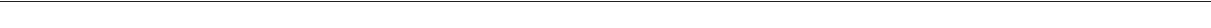
Fig. 6 Analysis of apoptotic vulnerabilities a – h Cells were incubated with increasing concentrations of the a BCL-X L -speci fi c inhibitor, b BCL-2-speci fi c inhibitor, e MCL-1 and g XIAP-speci fi c inhibitor for 96 h. Error bars are SEM ( n = 6 wells) and data is representative of three independent experiments. BCL-X L inhibitor c combined with PI3K/mTOR compared to BCL-2 d or MCL-1 f or XIAP h combinations. BCL-2-speci fi c inhibitor and BCL-X L -speci fi c inhibitor combinations with PI3K/mTOR inhibitor are dosed at 1 μ M, while MCL-1 and XIAP combination are dosed at 3 μ M. Data is representative of three independent experiments. i Effects of triple MCL-1 (dashed curve) or XIAP drug combination (dotted curve) combined with ABT-737 and GNE-493 for a resistant (DF83) PDX model. MCL-1 and XIAP inhibitors are at a constant concentration of 3 μ M, while ABT-737 and GNE-493 increase from 0.03-3 μ M. j Sensitivities (area under the curve values) for the triple combination therapies highlight the increased potency of MCL-1 compared to XIAP inhibition and the intertumoral heterogeneity. Data represents average from three independent experiments (error bars are SEM, n = 3) and is derived from experiment